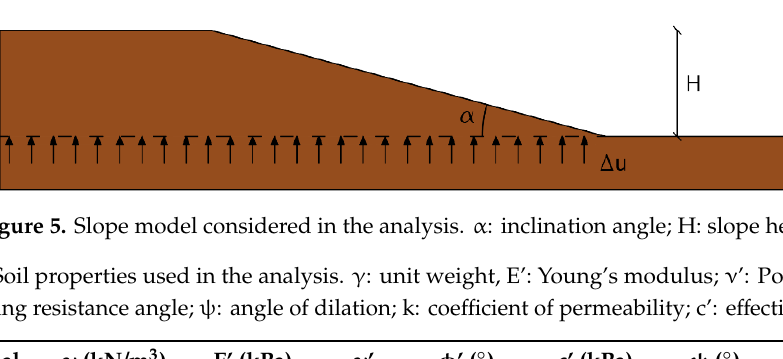
Figure 5. Slope model considered in the analysis. α : inclination angle; H: slope height.